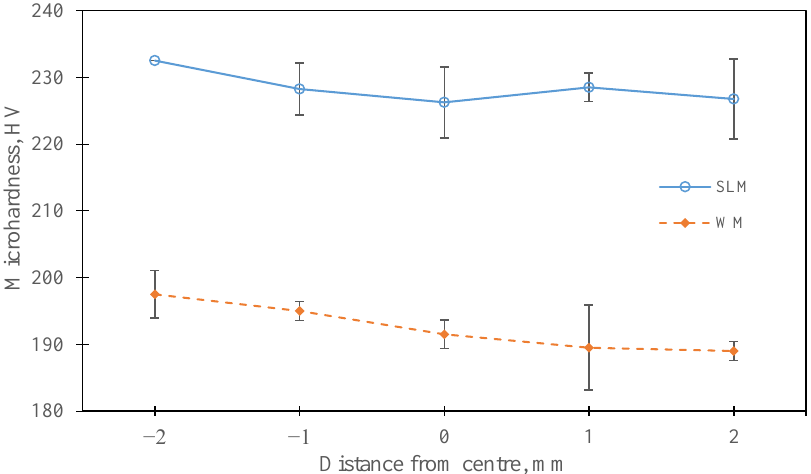
Figure 11. Average microhardness (HV) values for SLM and WM specimens.